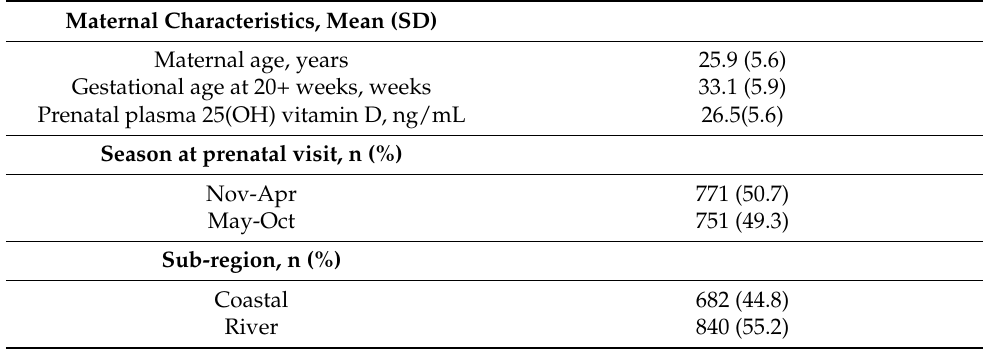
Table 1. Characteristics of prenatal women 20+ weeks gestation with vitamin D testing, Yukon Kuskokwim Delta, 2015–2019 (N =